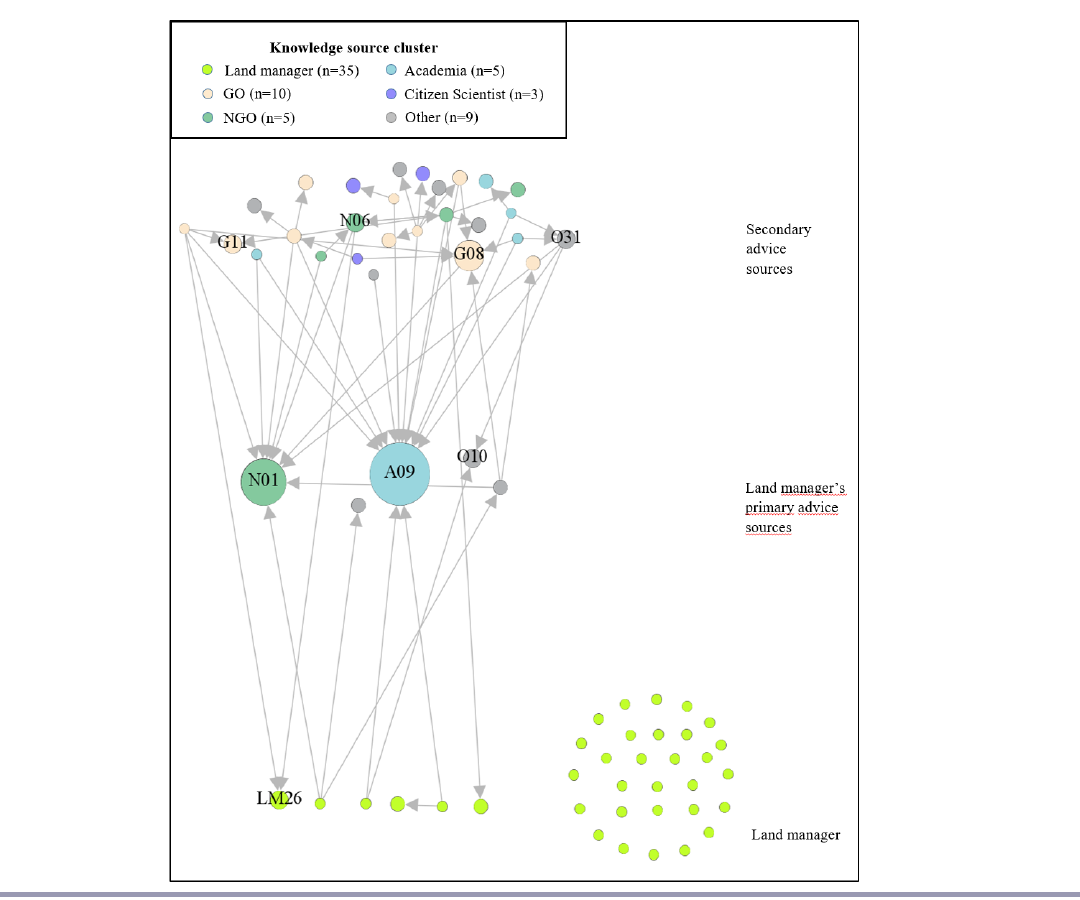
Fig. 3. Network diagram of the advice network for renosterveld conservation. The color of a node represents the knowledge source cluster the individual is associated with; GO = governmental organization, NGO = nongovernmental organization. The size of the node indicates the in-degree centrality (number of links entering the node). Labels are shown for stakeholders with an in-degree ≥ 2. Arrows point to the advice source that was named. Twenty-nine landowners did not have any advice source. A09 had the highest in-degree centrality ( N = 13), followed by NGO01 ( N =